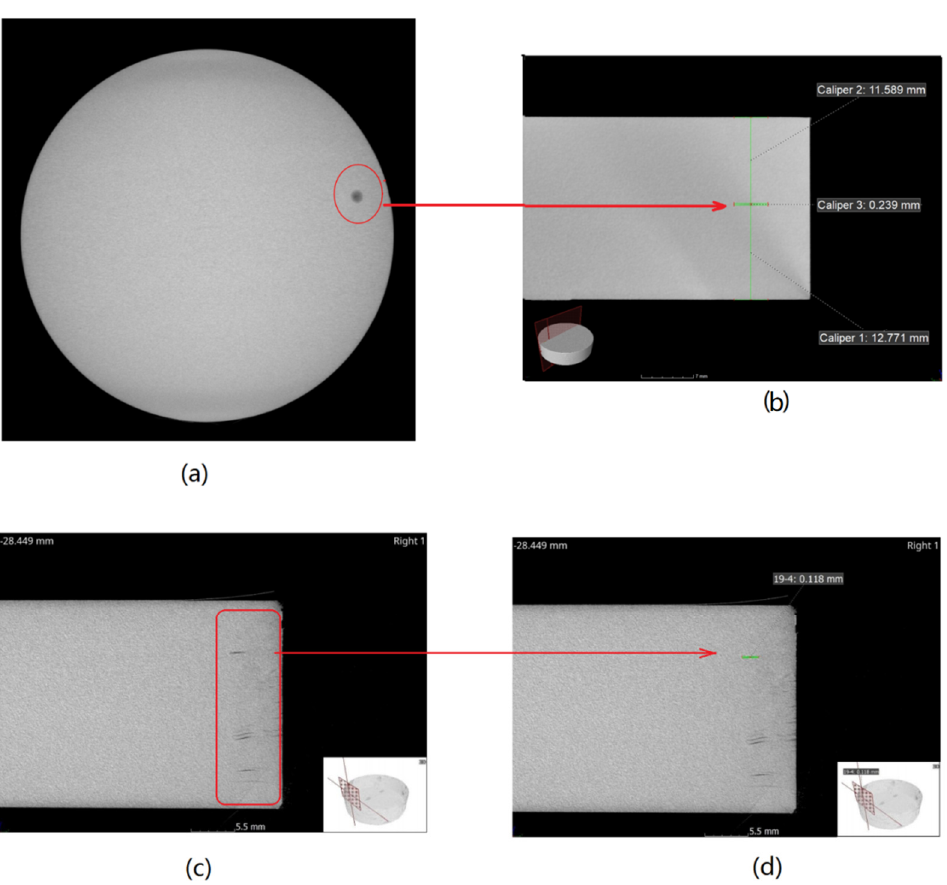
Figure 9. Cathode ray images of a disc multi-layer PP insulator, the total thickness is 20 mm; each layer has a thickness of 25 µ m; the layers are stuck via PI film of 12.5 µ m. ( a ) Top view of Sample A; ( b ) sectional view of Sample A with caliper; ( c ) sectional view of Sample B; ( d ) sectional view of Sample B with caliper.